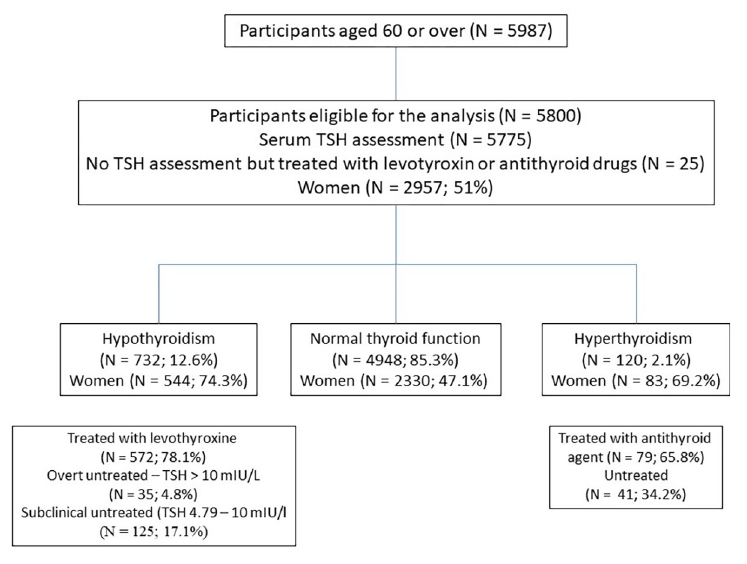
Fig 1. Chart flow of the